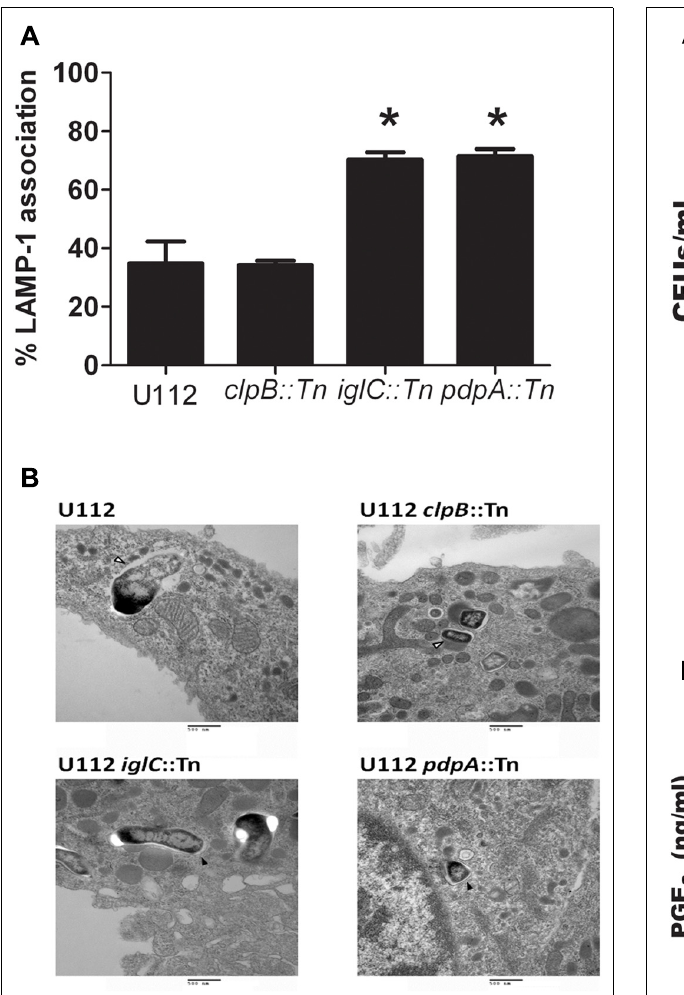
FIGURE 4 | Induction of PGE 2 does not require full escape from the phagosome. (A) Bacterial association with LAMP-1 was scored using Volocity ( n ≥ 20 imaged cells per strain with an average of one bacterium per macrophage). Co-localization was determined by the shared of red and green pixels at the same location. Data represents three independent experiments and expressed as the mean ± SEM. Asterisk “*” denotes statistical difference ( p ≤ 0.05) from U112-infected cells. (B) BMDMs were inoculated with U112, U112 clpB ::Tn, U112 iglC ::Tn, or U112 pdpA ::Tn at an MOI of 500:1. Association of the bacterium with the phagosomal membrane was determined 4 h post-inoculation using transmission electron microscopy. Open arrowheads denote bacteria no longer surrounded by an intact phagosomal membrane. Filled arrowheads denote bacteria surrounded by a phagosomal membrane.